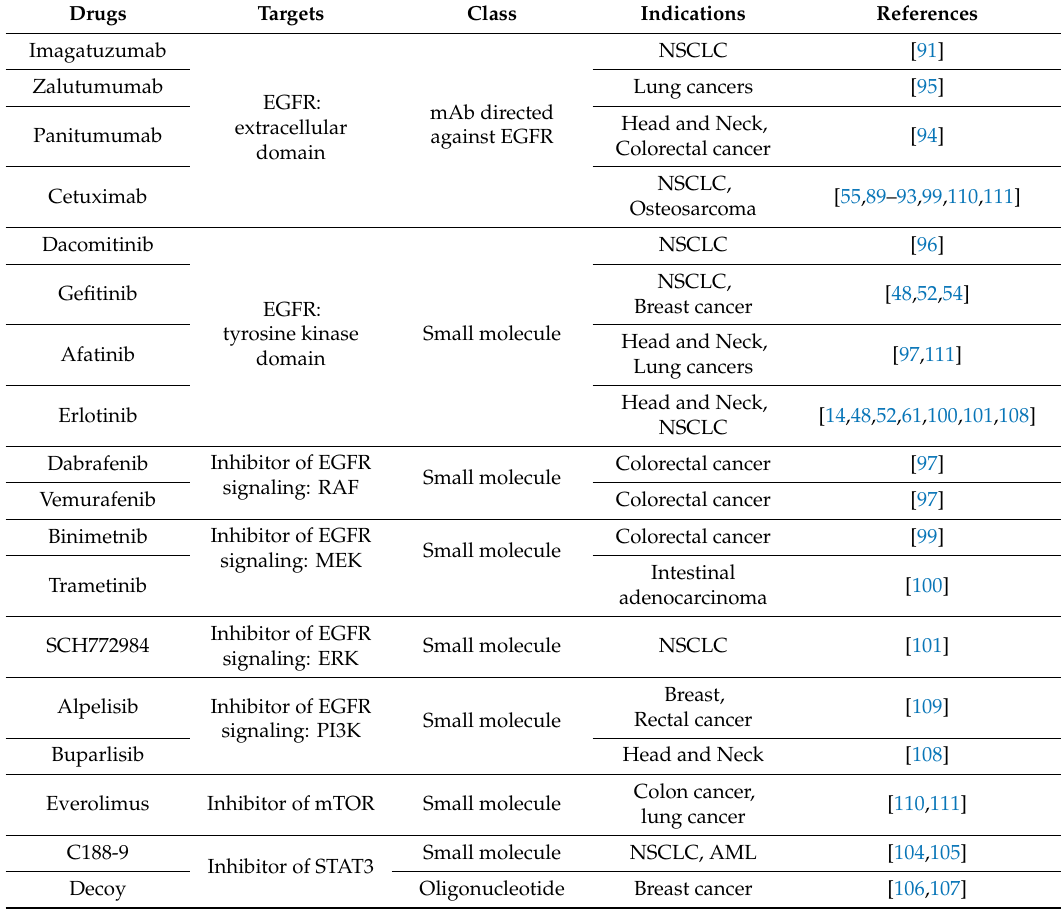
Table 1. Summary of anti-cancer drugs targeting